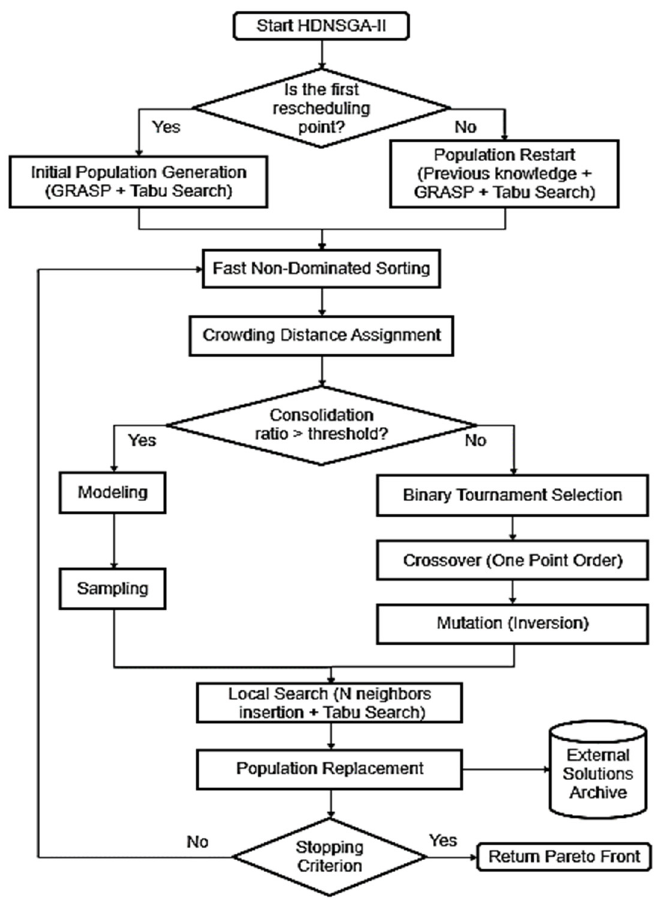
Figure 1. Flow diagram of the HDNSGA-II technique.